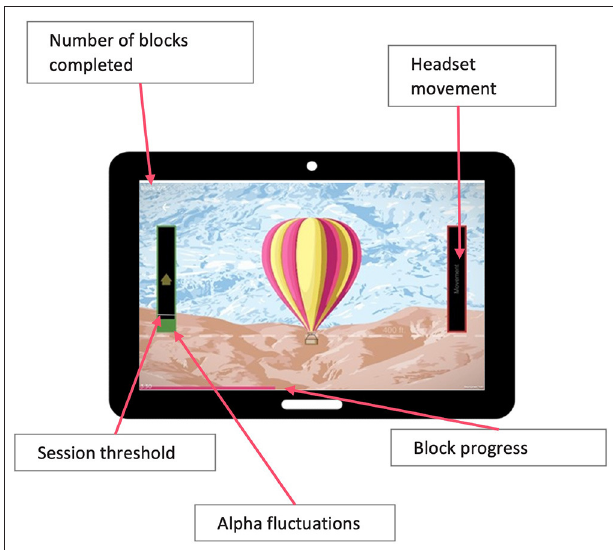
FIGURE 1 | Participants view during training sessions showing representation of their relative alpha threshold on a column to the left of the chosen